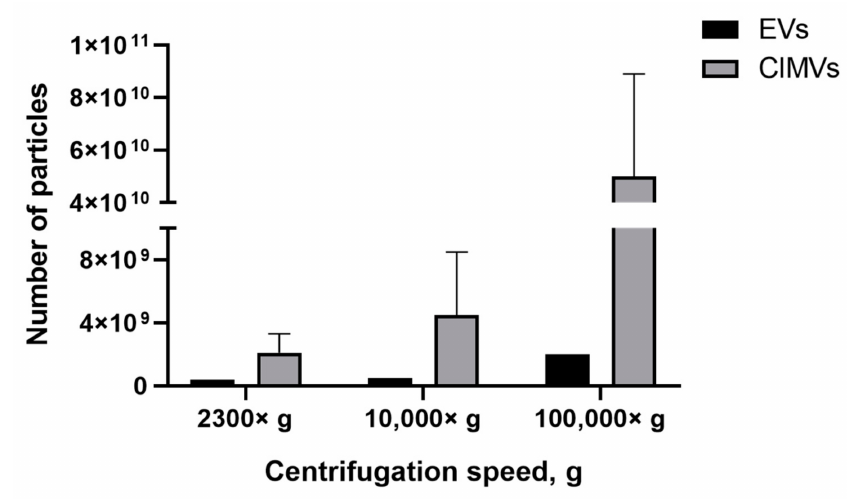
Figure 6. Analysis of EVs and CIMVs yields. Average number of EVs and CIMV after centrifugation 2300 × g , 10,000 × g , and 100,000 × g . NTA